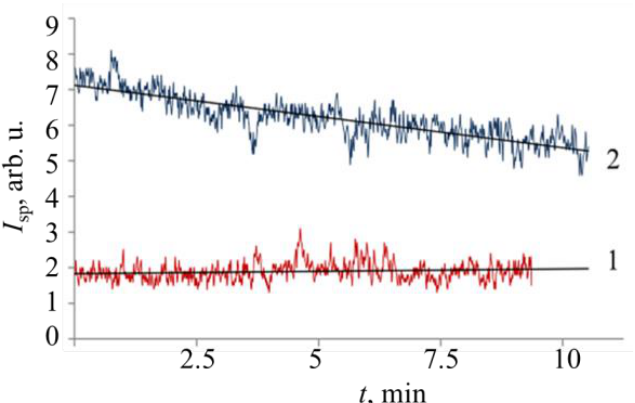
Figure 13. Time dependencies of scattering intensity fluctuations, I sp measured in the cell of planar multichannel chip (Figure 12) for the suspension of E. coli M-17, c = 10 8 CFU/mL (1) and the same with the addition of ceftriaxone (2) at the concentration of 1.0 mg/mL.